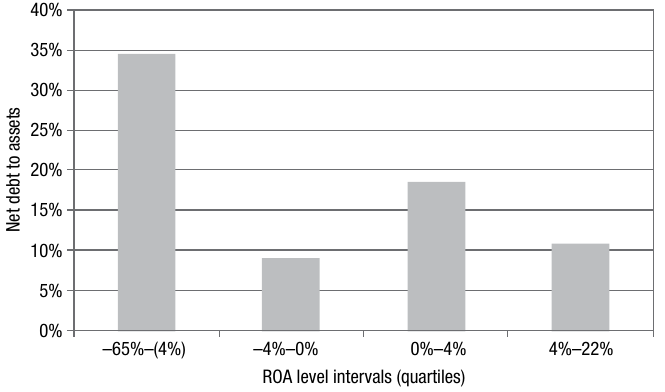
Fig. 3. Net debt level according to ROA quartiles (FY